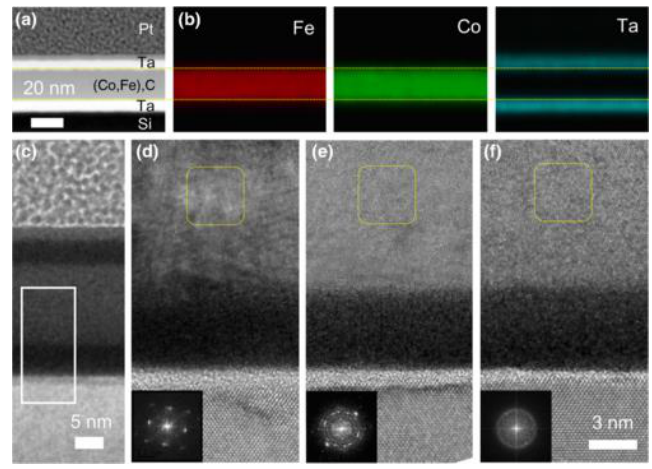
Figure 14. ( a ) A bright-field STEM image of Ta/(Co,Fe)C/Ta/SiO2/Si (001) substrate. ( b ) The corresponding energy-dispersive x-ray spectroscopy mappings for Fe, Co, and Ta elements, respectively. ( c ) Cross sections of lowresolution TEM with white solid rectangle displaying the corresponding location of HRTEM. ( d )–( f ) HRTEM images of Co-Fe-C alloy films with carbon content 0%, 4.4%, and 13.2%, respectively. The FFT of selected zones (yellow dotted squares) are inserted at the bottom left corner. Reproduced with permission from [112]. Copyright [2019], American Physical Society.